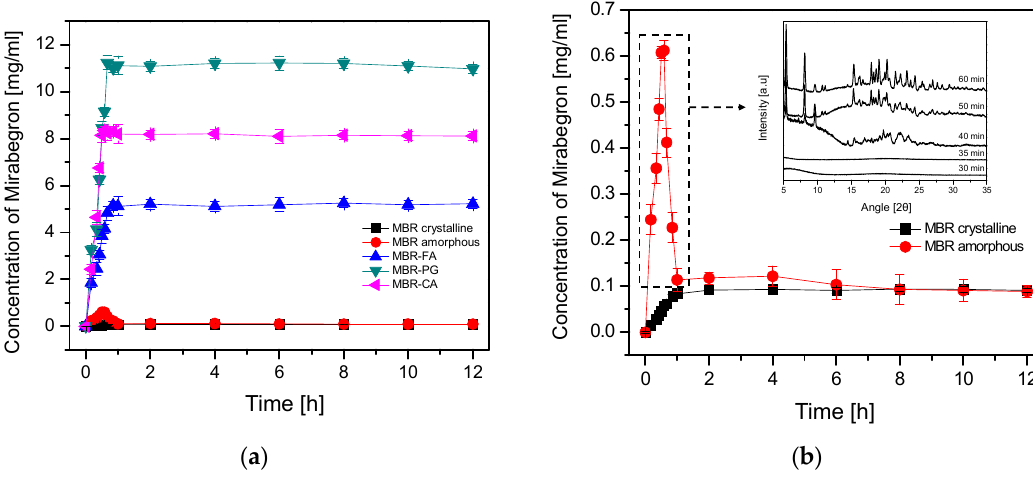
Figure 6. Dissolution profiles for MBR co-amorphouses, MBR crystalline solid, and MBR amorphous; ( a ) dissolution profiles of MBR co-amorphouses (MBR-FA, MBR-PG, and MBR-CA), MBR crystalline solid, and MBR amorphous at 37 °C; ( b ) dissolution profiles of MBR crystalline and MBR amorphous at 37 °C and monitoring of MBR amorphous phase transformation using PXRD.